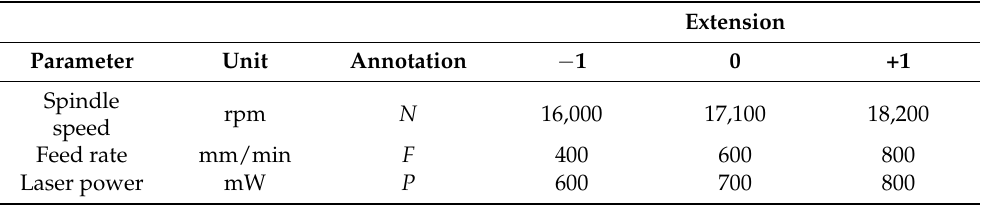
Table 6. Input processing parameters based on central composite design